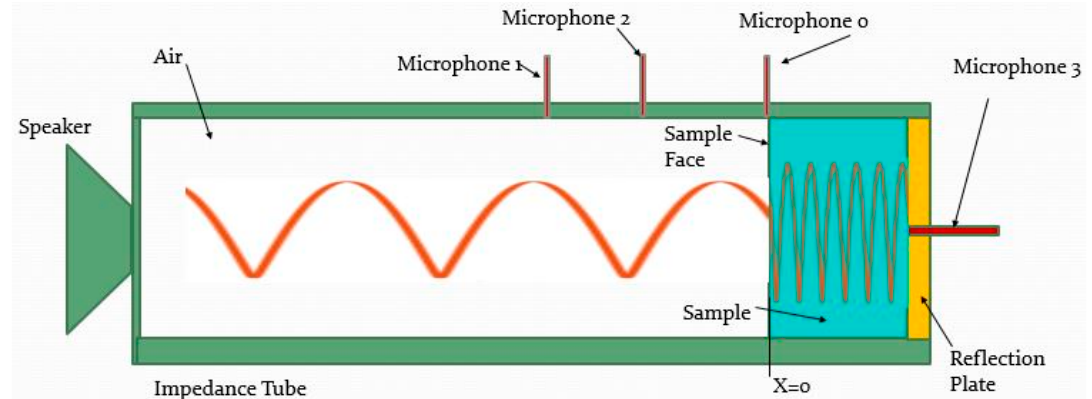
Figure 1. Schematic diagram of the experimental apparatus detailing the testing configuration for performing the standard two-microphone method, the 1998 three-microphone method of Iwase et al., to obtain complex material propagation coefficients.